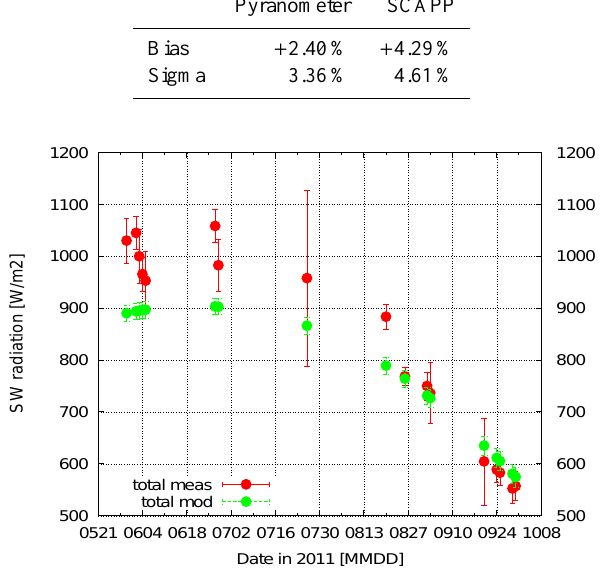
Figure 7. Shortwave radiation (total) measured at site Magdeburg / Saxony-Anhalt with SCAPP (red) and calculated (green). Note that identification of strong overestimation in July possibly due to wrong station setup caused a release of instrument substitution end of Au-